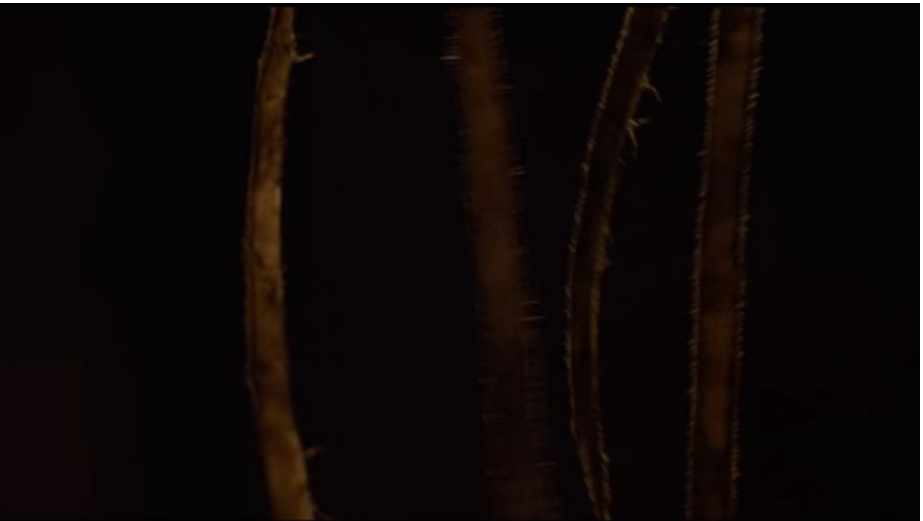
Figure 19. The Power of the Dog . Netflix.